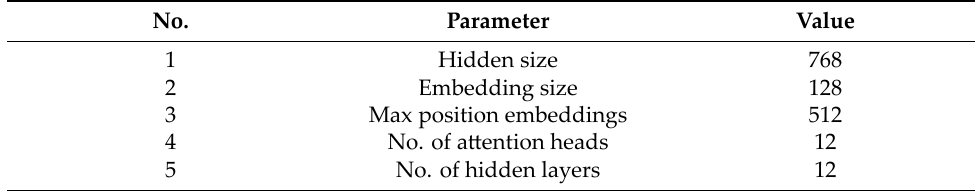
Table 8. ALBERT model